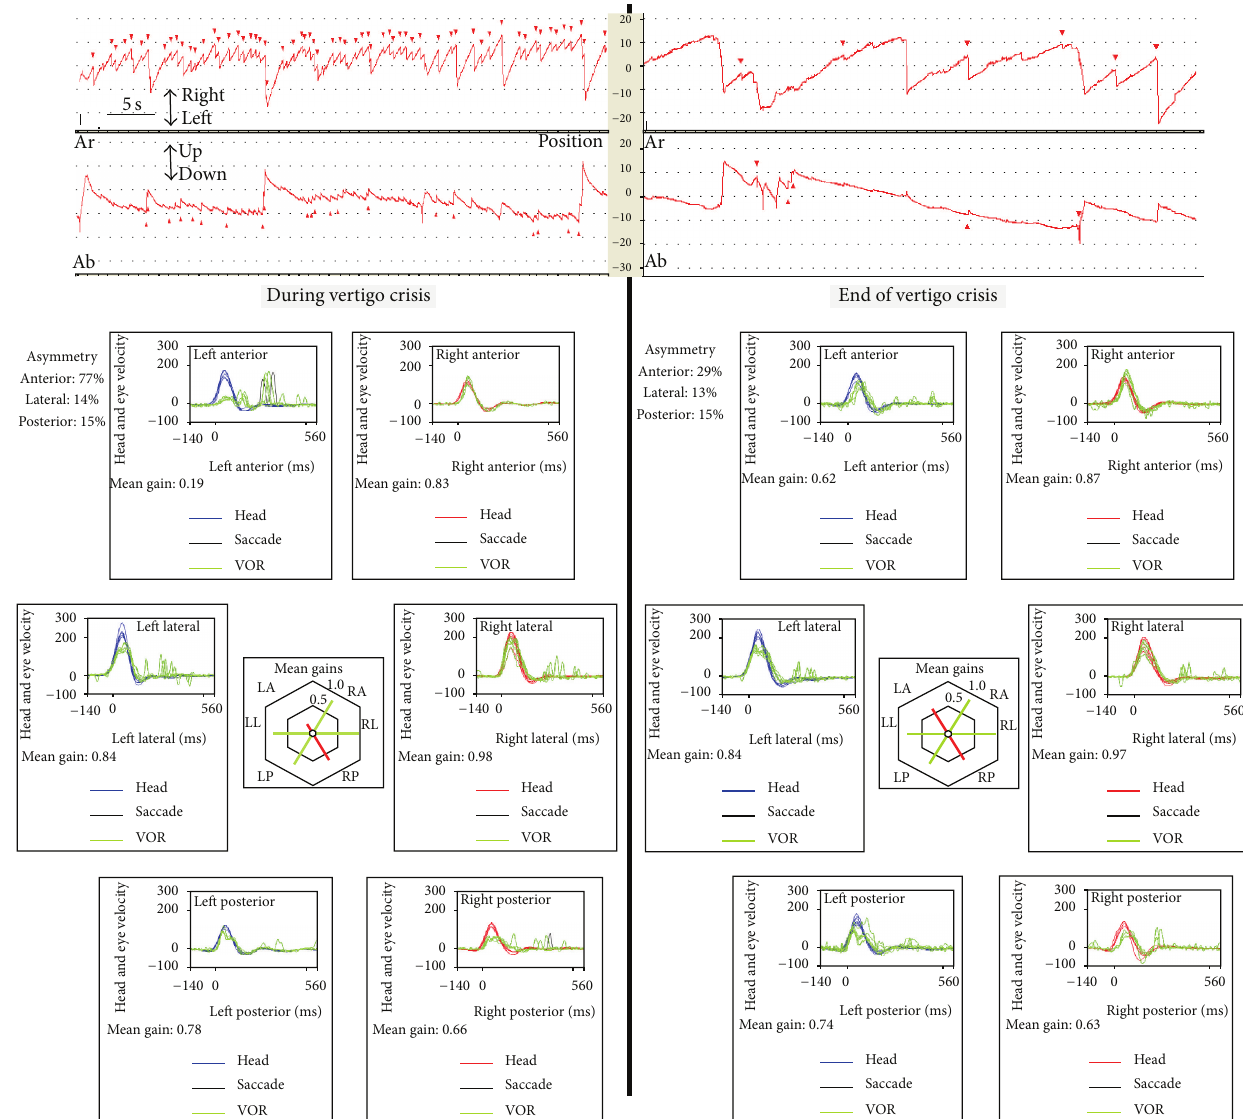
Figure 3: Spontaneous nystagmus and results of the video head-impulse test at the initiation of the crisis and at the end. Nystagmus is left beating with an upward component and there is a clear decrease in the gain of the vestibuloocular reflex in the plane of the left superior semicircular canal and right posterior canal (LARP) and the consequent presence of saccades. After the acute attack the same evaluation shows an increase of the gain and a significant decrease of the nystagmus.